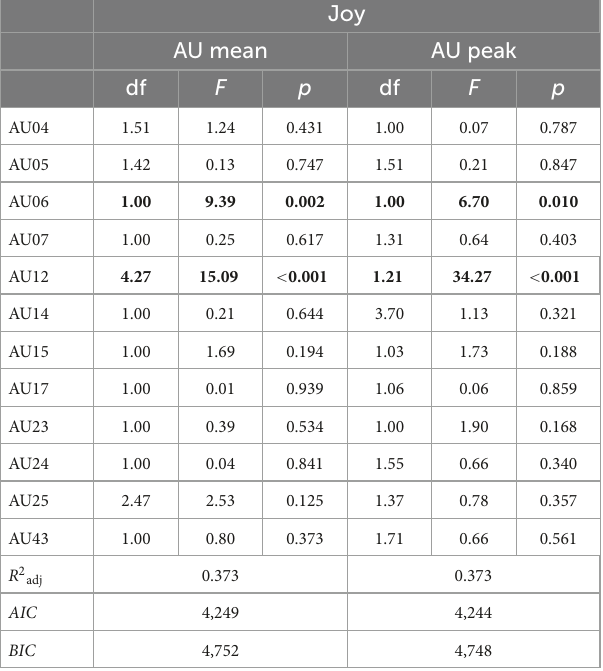
Significant coefficients are in bold. The models are controlled for gender and stimuli as fixed factors and participants and stimulus groups as random factors. AU04 = brow lowerer, AU05 = upper, lid raiser, AU06 = cheek raiser, AU07 = lid tightener, AU12 = lip corner pull, AU14 = dimpler, AU15 = lip corner depressor, AU17 = chin raiser, AU23 = lip tightener,